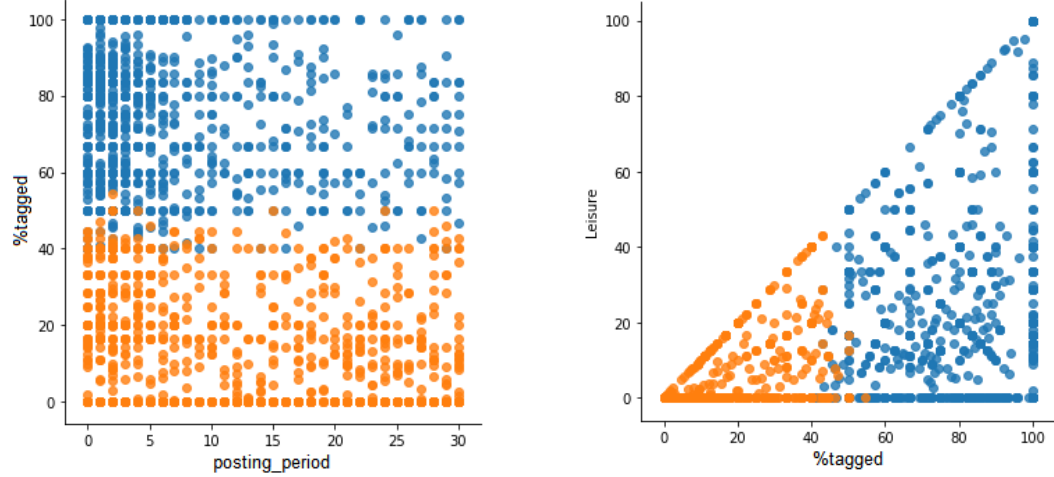
Figure 6. Classification of users according to clusters in Valencia.